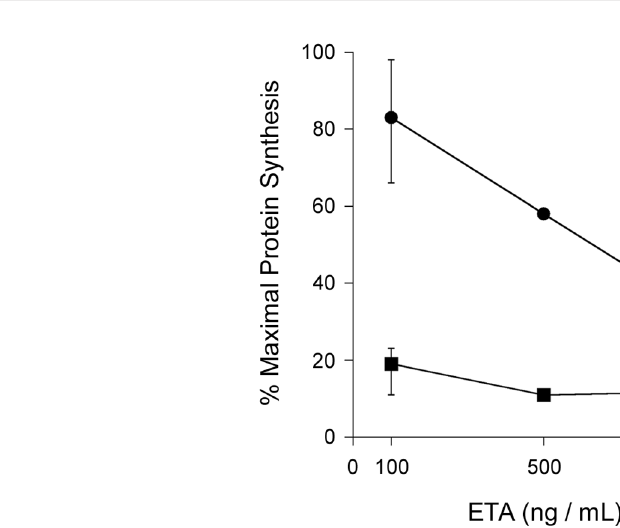
Hsp90 role in Hsp90 role in toxin terminus intoxication translocation